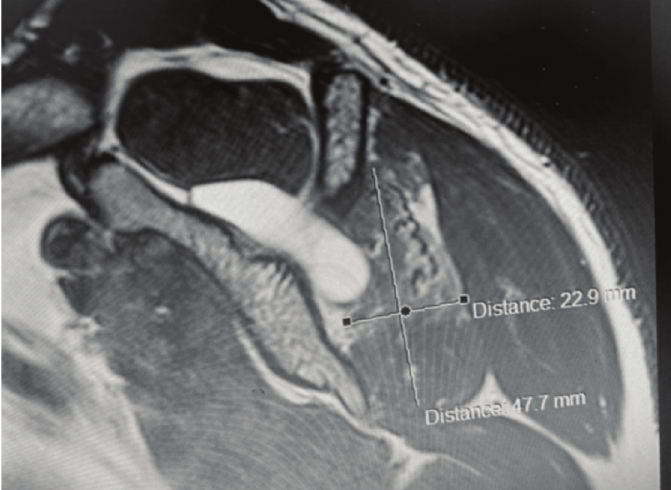
T2 weighted image showing a persistent spinoglenoid cyst of the shoulder following initial surgery. There is further atrophy of Fig. 2: the infraspinatus muscle compared to the earlier MRI